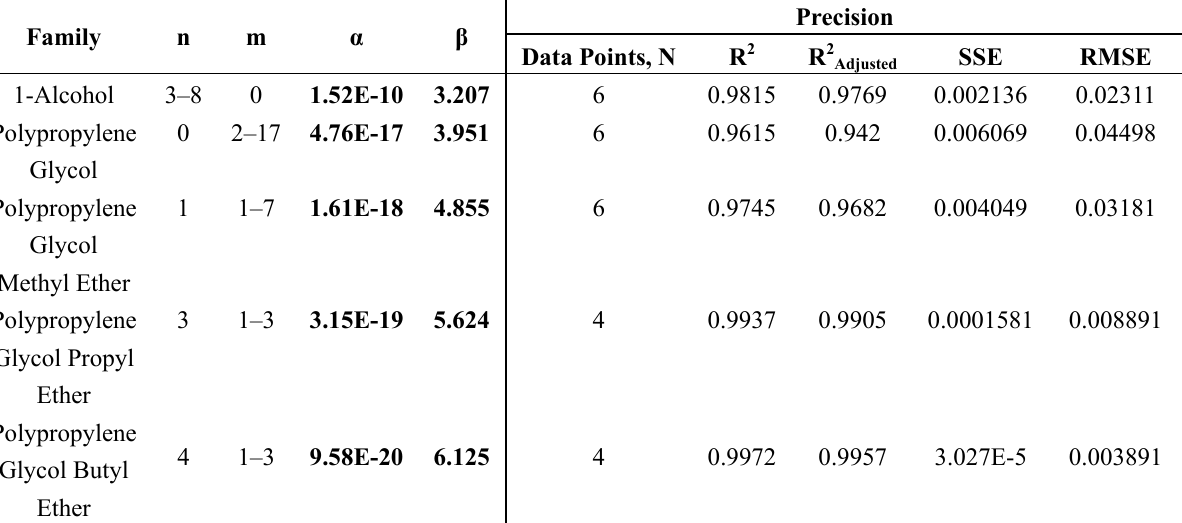
Table 5. The constants in Equation (6) for the range of n and m and goodness-of-fit (precision)